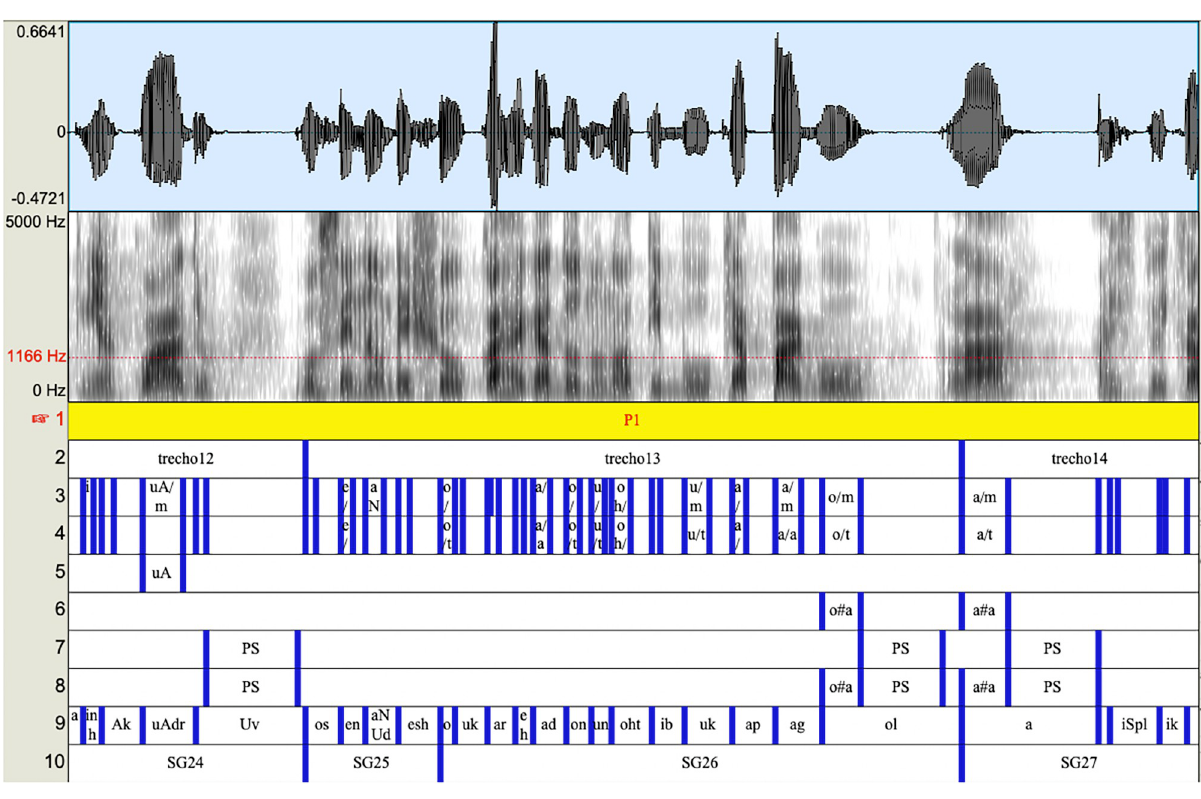
Fig 1. Data segmentation and